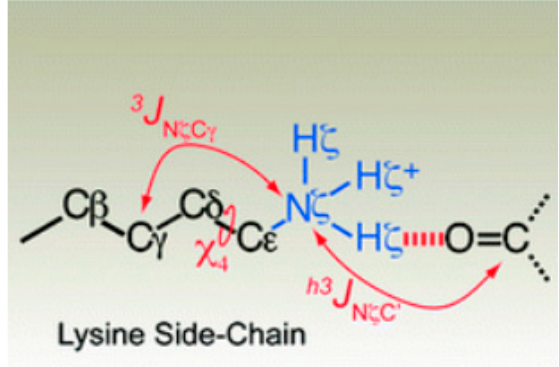
Figure 16. Coupling from at carbonyl carbon to a side ‐ chain lysine N via the hydrogen bond. Taken from [69] with permission from The American Chemical Society.